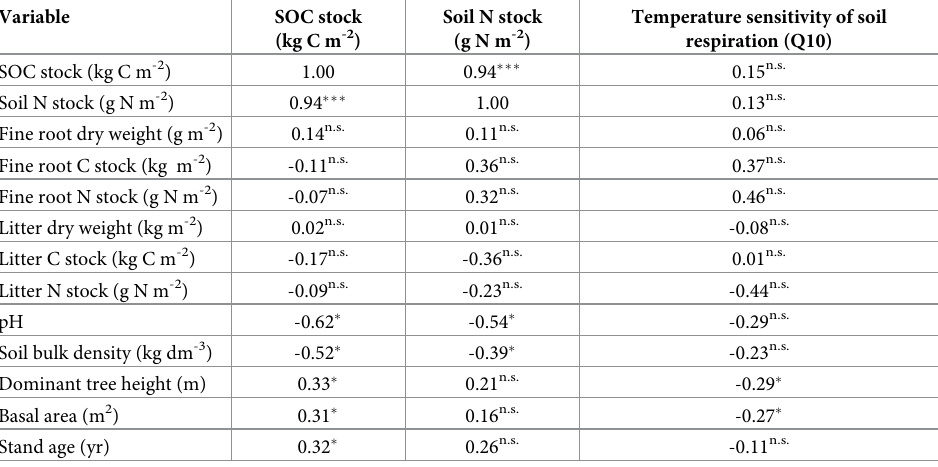
Table 3. Spearman rank coefficients for the correlations between different variables.